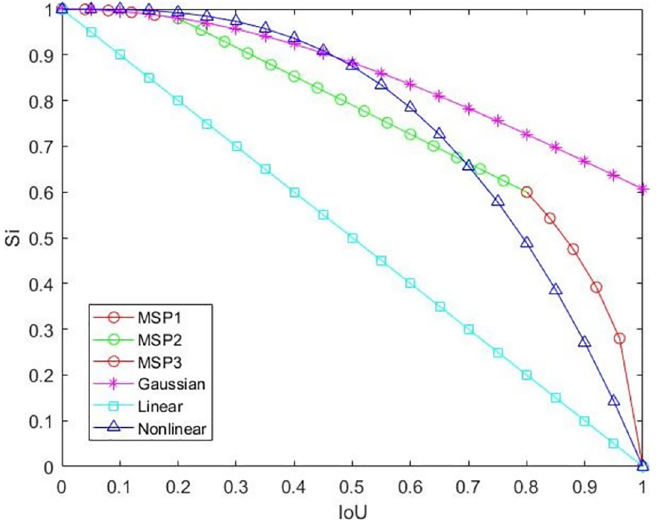
Fig 7. Function graphs of different penalty